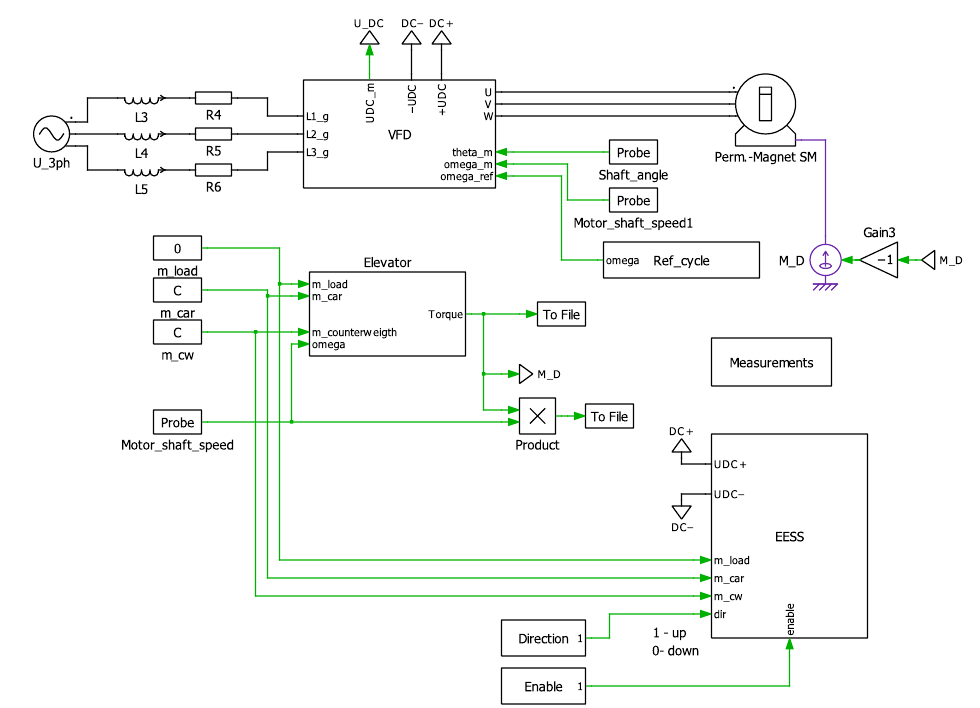
Figure 10. Simulation model of the elevator system with